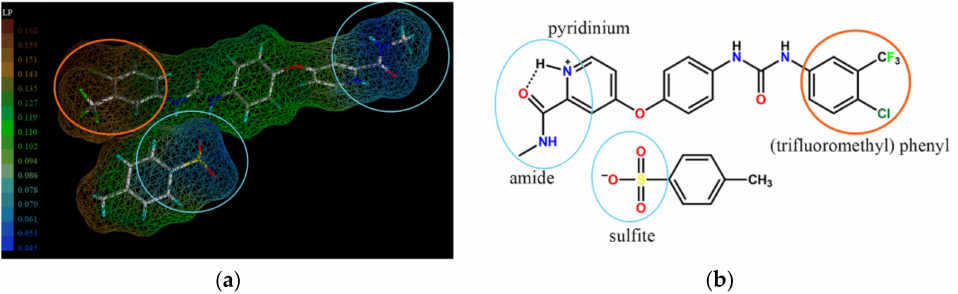
Figure 5. ( a ) LP analysis of Sor-Tos, moving from orange to blue on the scale, indicates increasing hydrophilic potential. ( b ) The corresponding molecular structure of Sor-Tos. The hydrophilic and hydrophobic moieties of Sor-Tos are shown in light blue and orange circles,